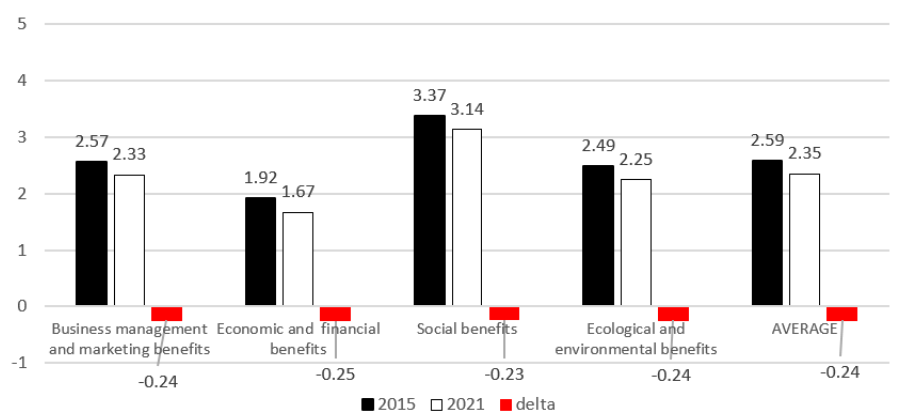
Figure 5. Differences in EMAS benefits assessed by registered organisations.